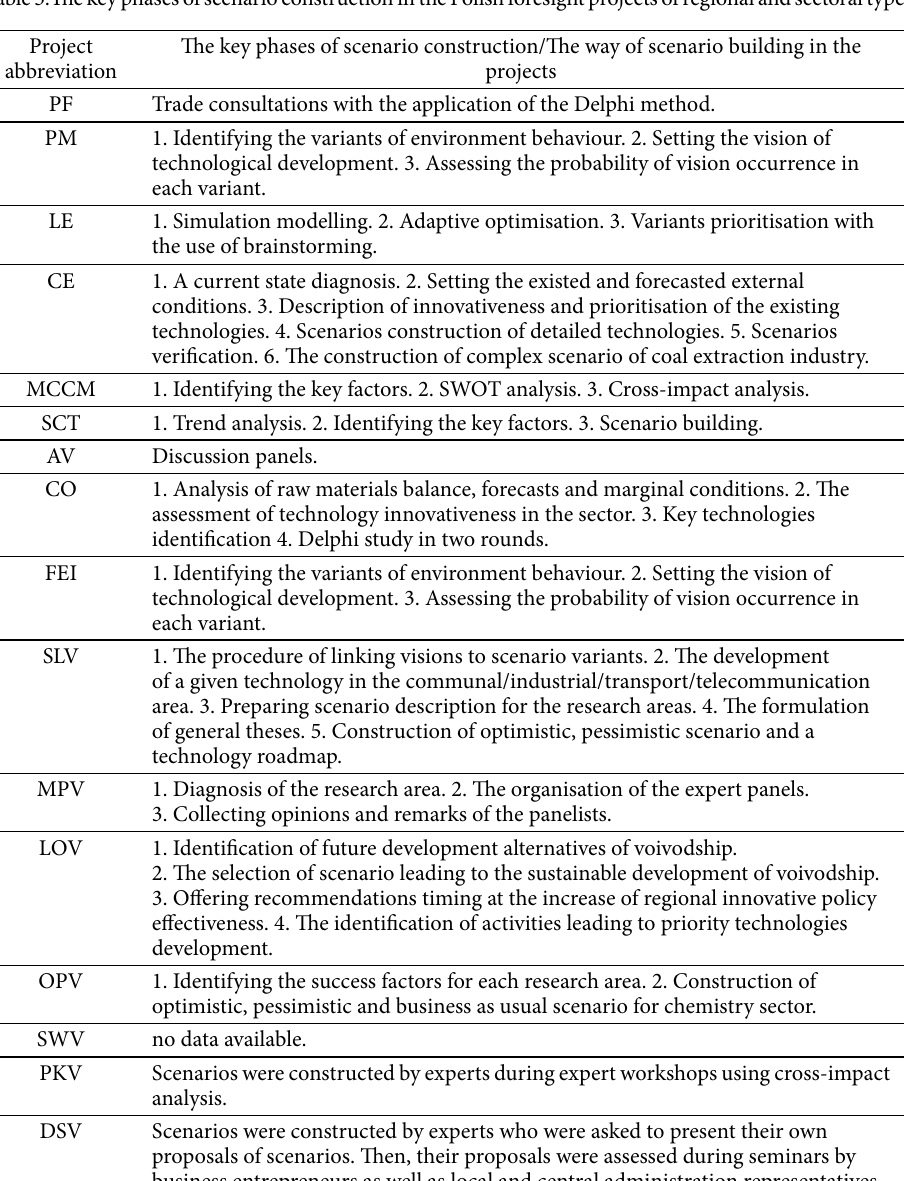
Table 3.The key phases of scenario construction in the Polish foresight projects of regional and sectoral type Project